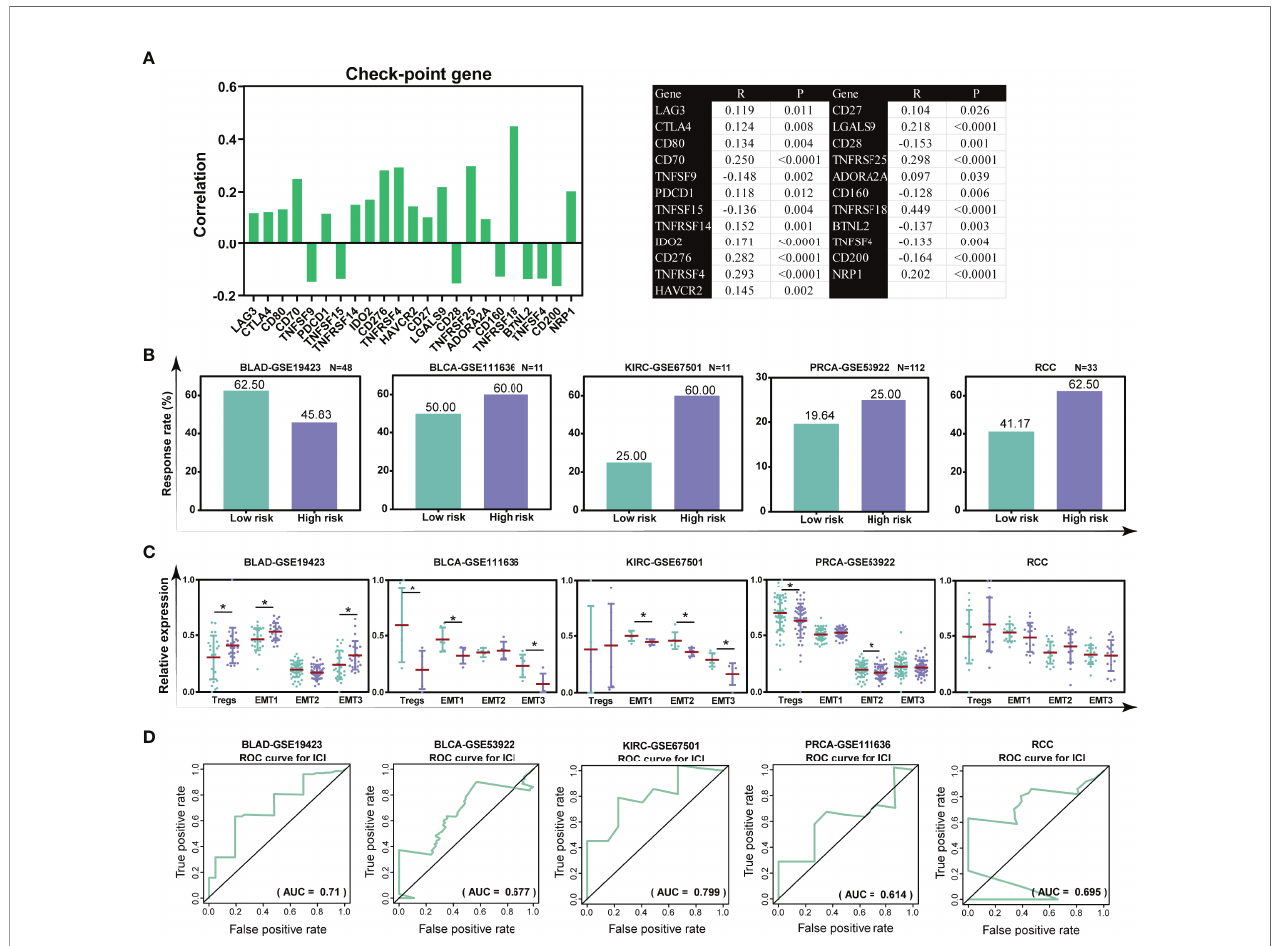
FIGURE 7 | The TILTregSig is a potential predictor for immunotherapy response in prostate cancer. (A) The correlation of the risk scores with the expression levels of checkpoint genes in prostate cancer samples from the TCGA dataset. R : Spearman ’ s correlation coef fi cient. (B) The response rate to immunotherapy in low- and high-risk groups strati fi ed by risk scores in each dataset. (C) The distribution of the Treg in fi ltration and EMT activity among samples in low- and high-risk groups in each dataset. (D) ROC curves of the TILTregSig in predicting immunotherapy response in each dataset. *,